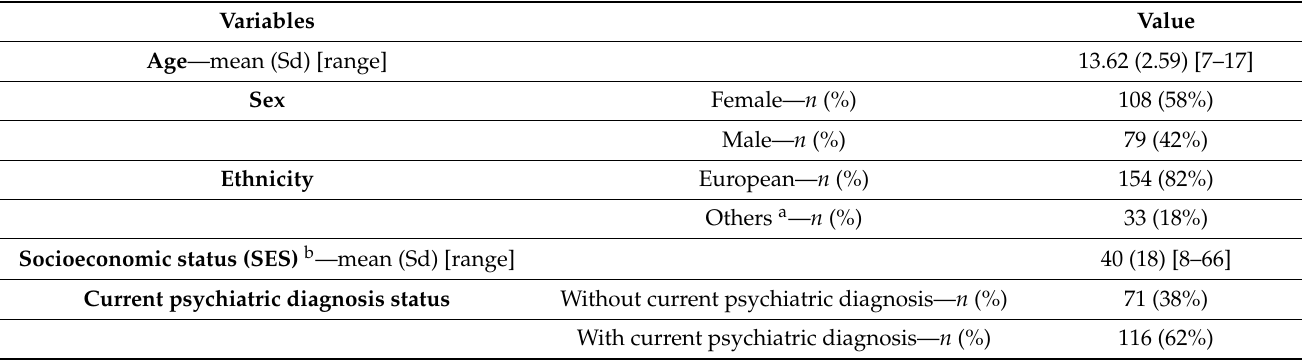
Table 1. Demographic and clinical descriptive data of our sample ( n =